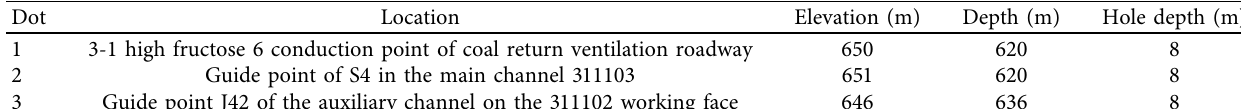
Table 2: Borehole parameters table at measuring point.